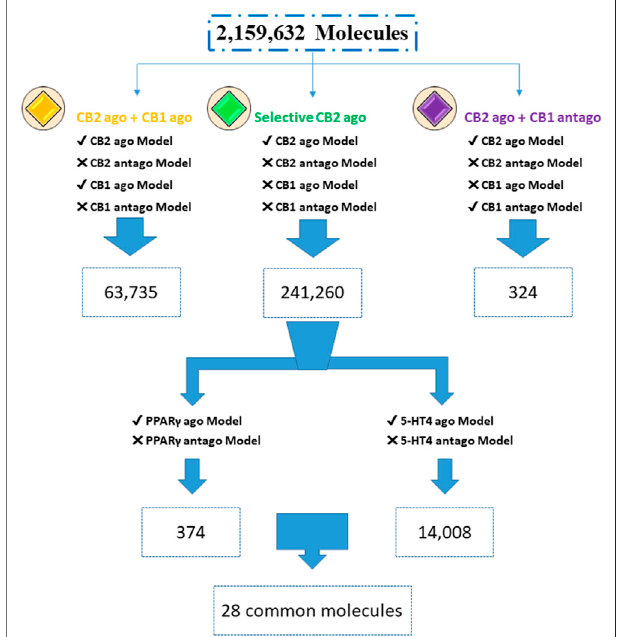
FIGURE 1 | Screening for multitargeted candidates. Enamine database (2,159,632 compounds) was screened through agonist (ago) and antagonist (antago) ISE models. Numbers are of molecules with a positive index for models with a “ ✓ ” symbol, while failing to pass the models is marked by “ X ” (due to a negative